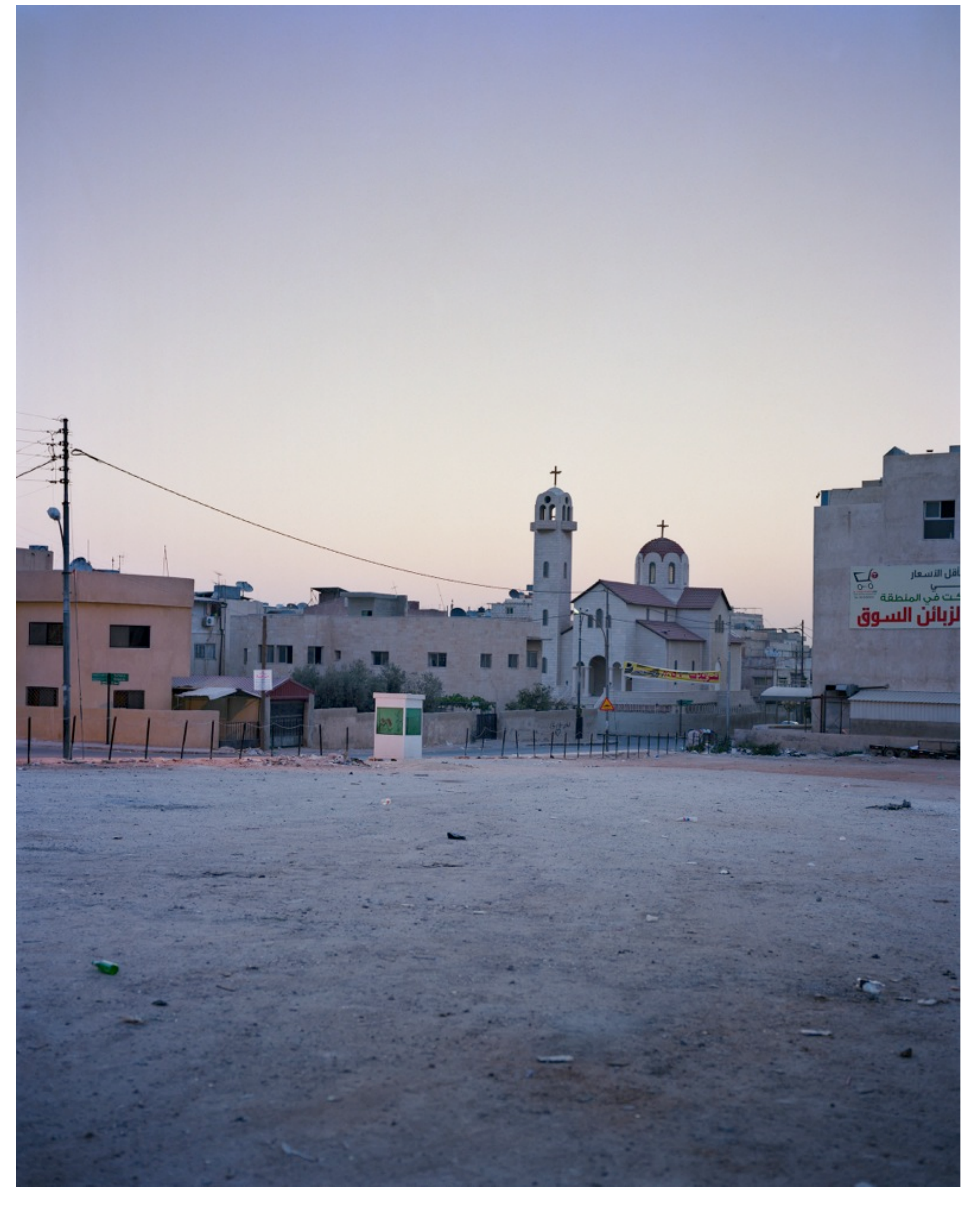
Figure 8 Regina Mamou, Untitled (Dawn, Hashimi) from the series Mapping Collected Memory, 2009–2010. Digital C-print. 40 x 32 in. (101.60 x 81.28